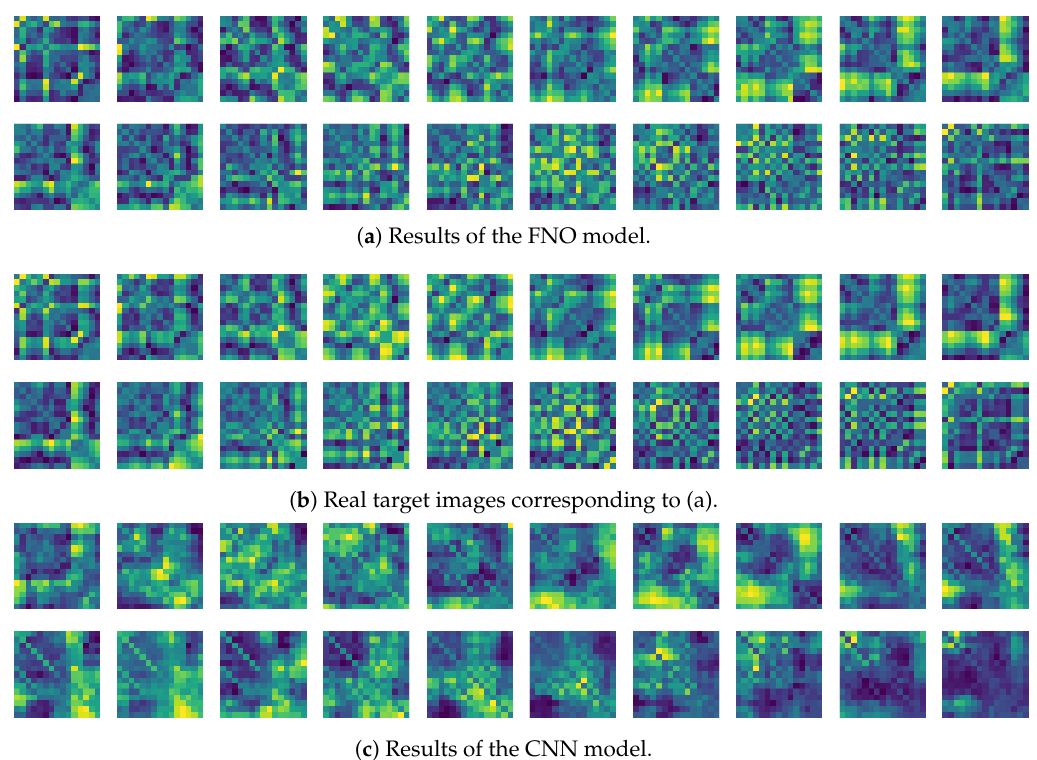
Figure 26. Some samples for running